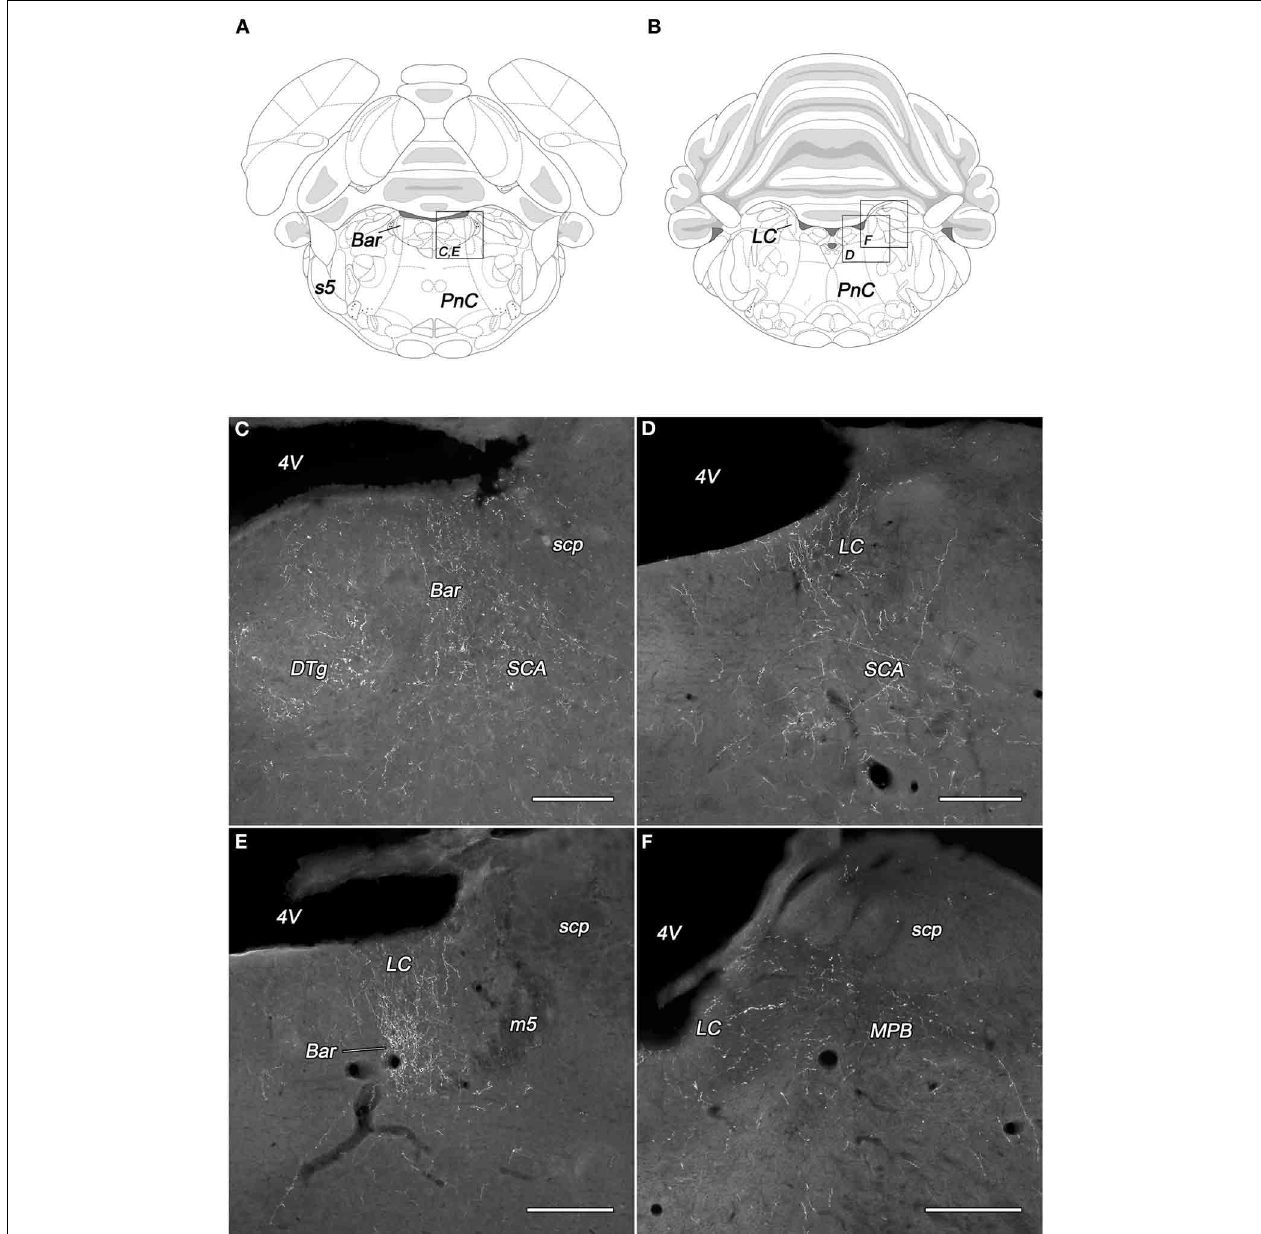
FIGURE 5 | Labeled fibers in the locus coeruleus and the Barrington’s nucleus following BDA injections into different subregions of the DLH. Drawings with outlined areas for panels C and E (A) and panels D and F (B) according to the atlas of Paxinos and Watson (2007), with modifications. Fine, moderately dense varicose fibers are seen in the Barrington’s nucleus, the dorsal tegmental nucleus, and the subcoeruleus area following caudomedial perifornical injections (C) . BDA-containing fibers in the rostral locus coeruleus originating from the caudomedial perifornical area (D) .